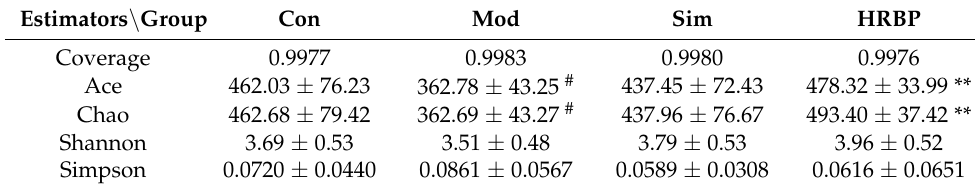
Table 2. Alpha diversity